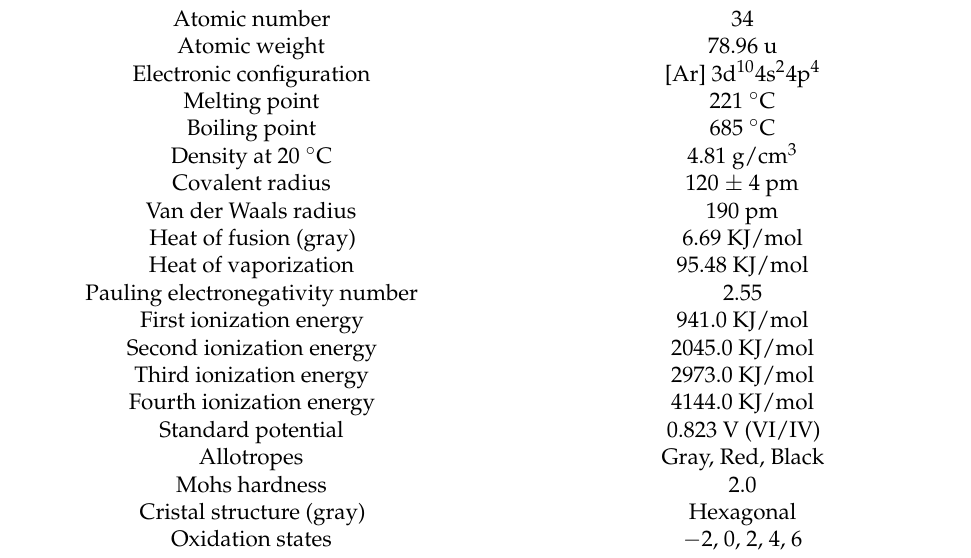
Table 1. Chemical and physical properties of selenium.